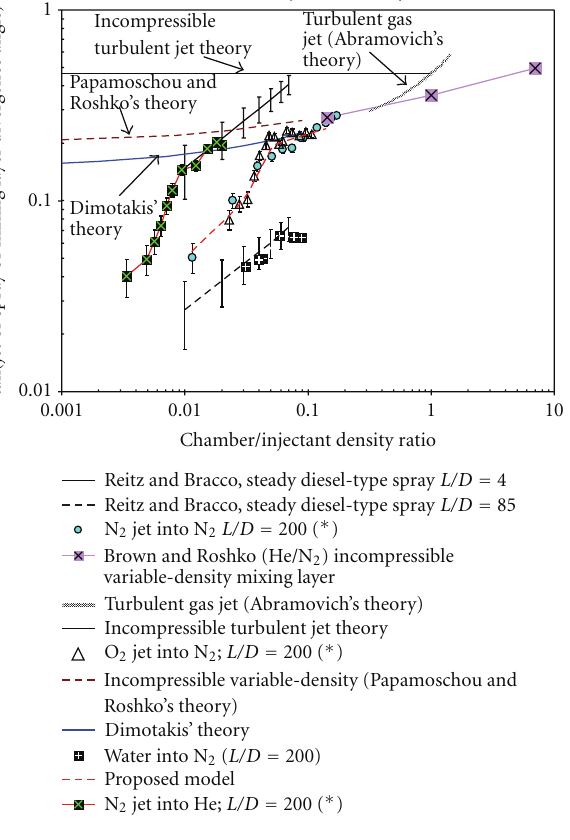
Figure 5: Spreading or growth rate of single jets as a tangent of the visual spreading angle versus the chamber-to-injectant density ratio. Data taken by Chehroudi are indicated by an asterisk ( ∗ ) in the legend. Chehroudi et al.